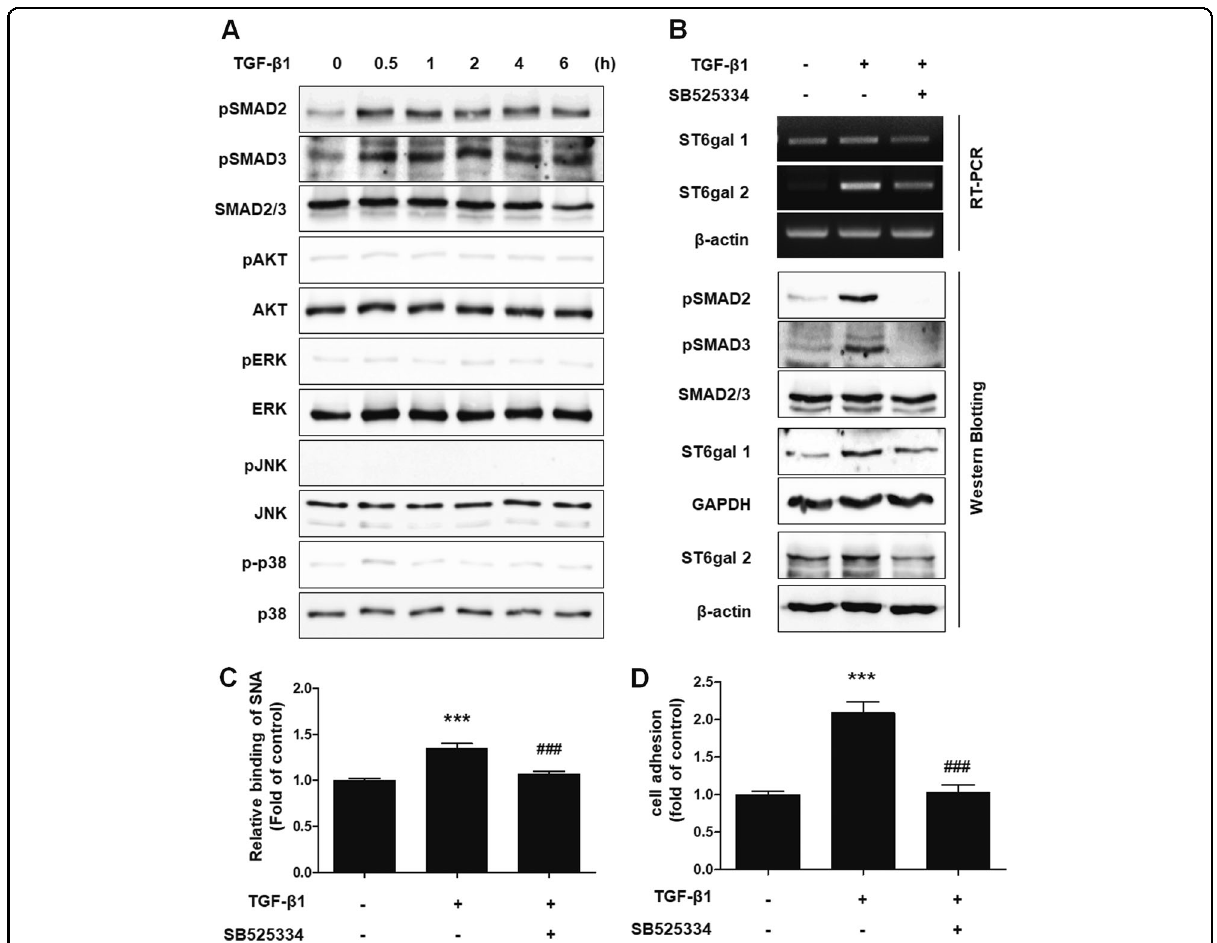
cells were cultured with TGF- β 1 (10 ng/mL) according to the indicated times. Phosphorylation levels of SMAD2, SMAD3, Akt, ERK, JNK, and p38 were examined by western blot analysis. b – d Ishikawa cells were treated with 10 μ M TGF- β RI inhibitor (SB525334) 1 h before TGF- β 1 (10